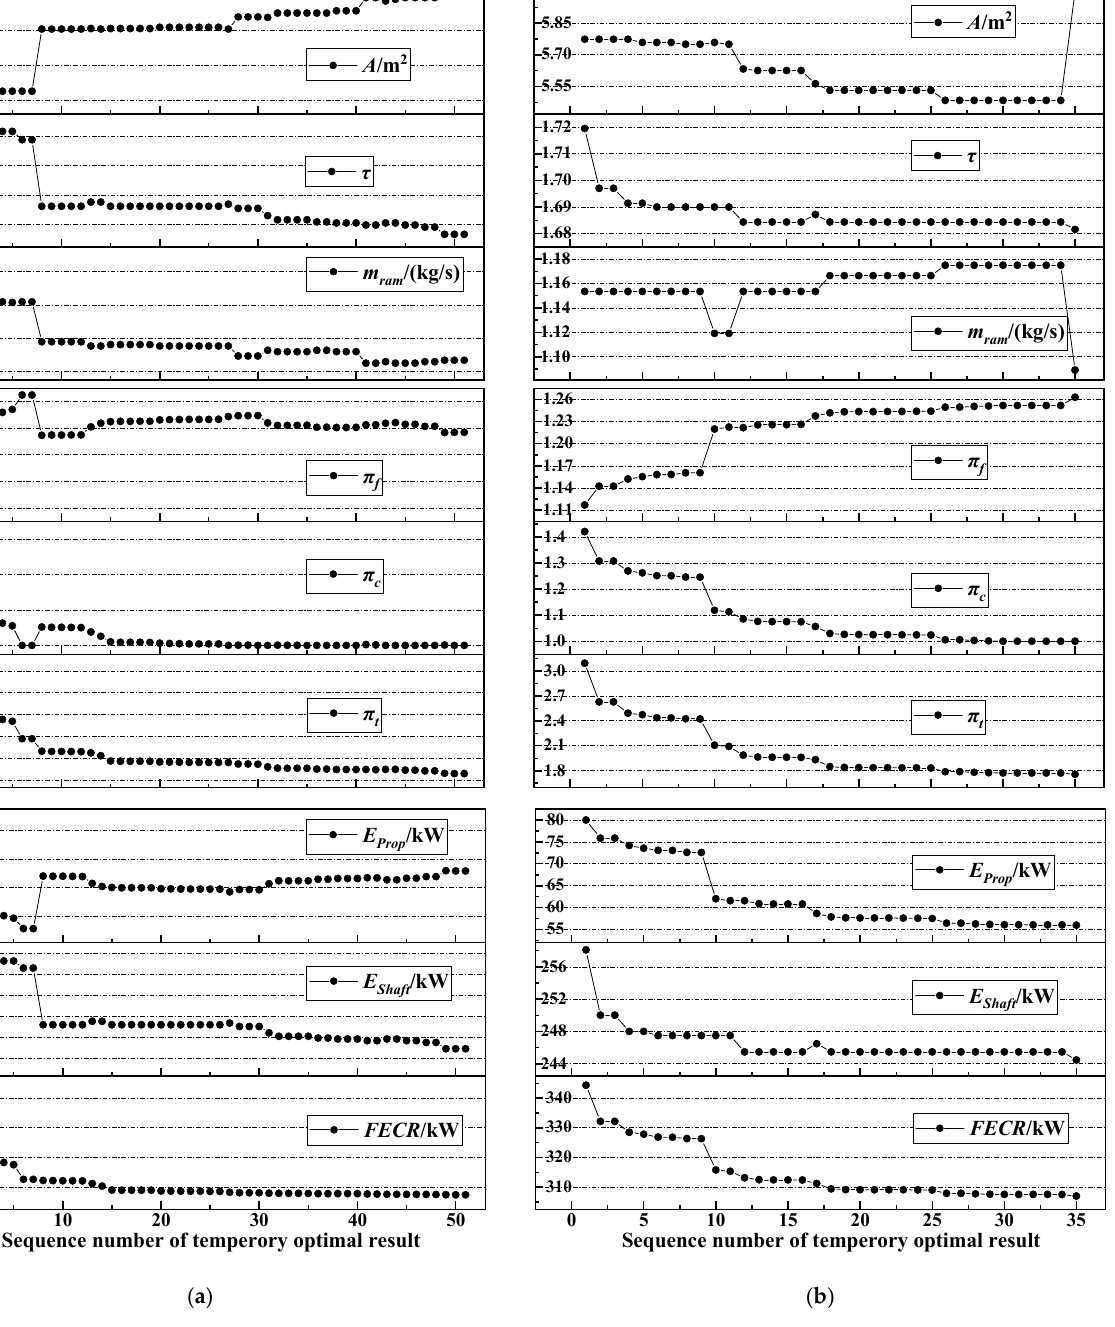
Figure 6. Variation of ECS parameters during optimization. ( a ) Optimization process of the 1st optimal result; ( b ) Optimization process of the 2nd optimal result.